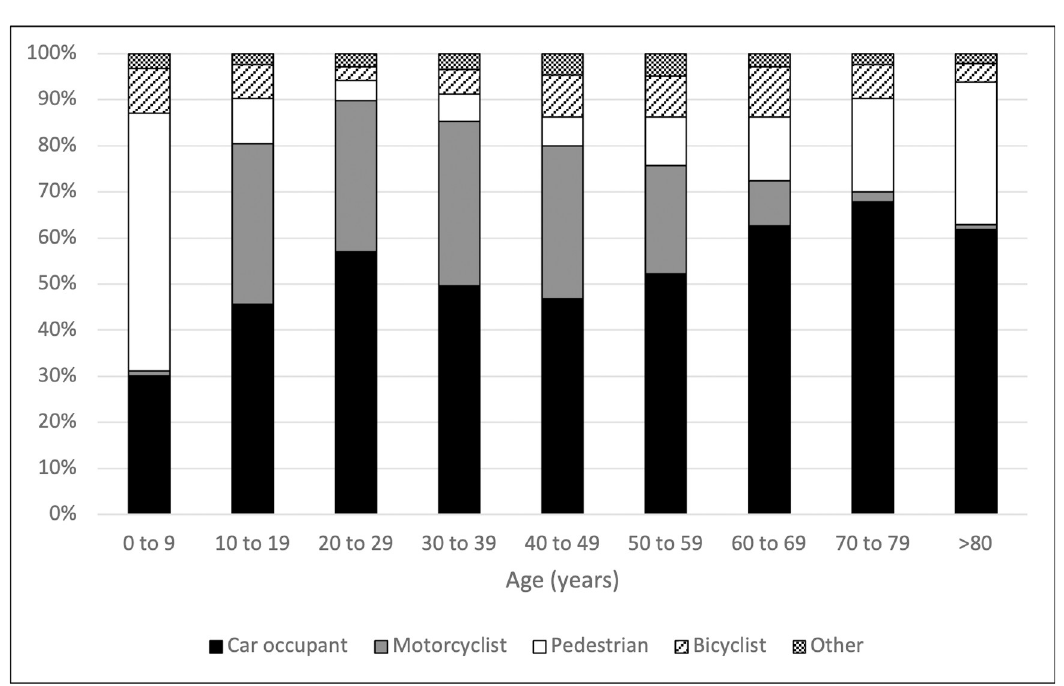
Fig 2. Road user category distribution among the AIS Thorax � 2 group. Subgroups according to the age. AIS Thorax � 2 group: trauma patients presenting with at least one thoracic injury AIS � 2. AIS: abbreviated injury scale. MAIS: maximum abbreviated injury